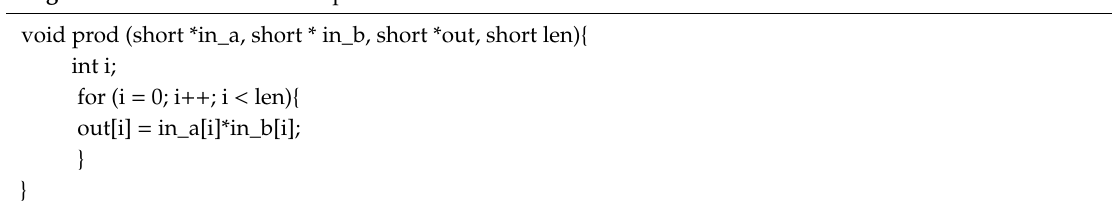
Algorithm 2. Calculate the dot product of two one-dimensional vectors of size 200